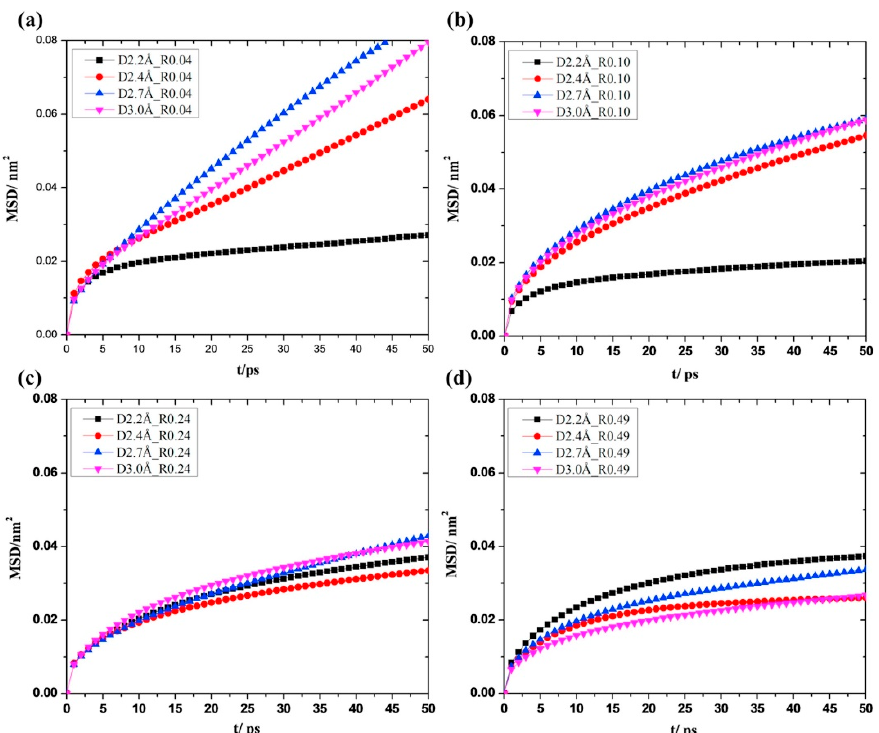
Figure 13. Water flux across GO monolayer membranes based on variable pore diameter and O/C ratio (R).